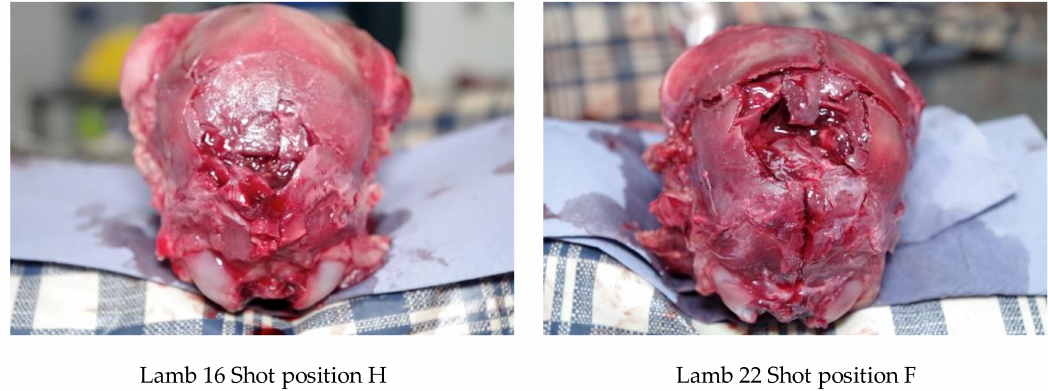
Figure 12. Comparative effects of sagittal shot position of neonate lambs, demonstrating greater fracturing with more cranial application.